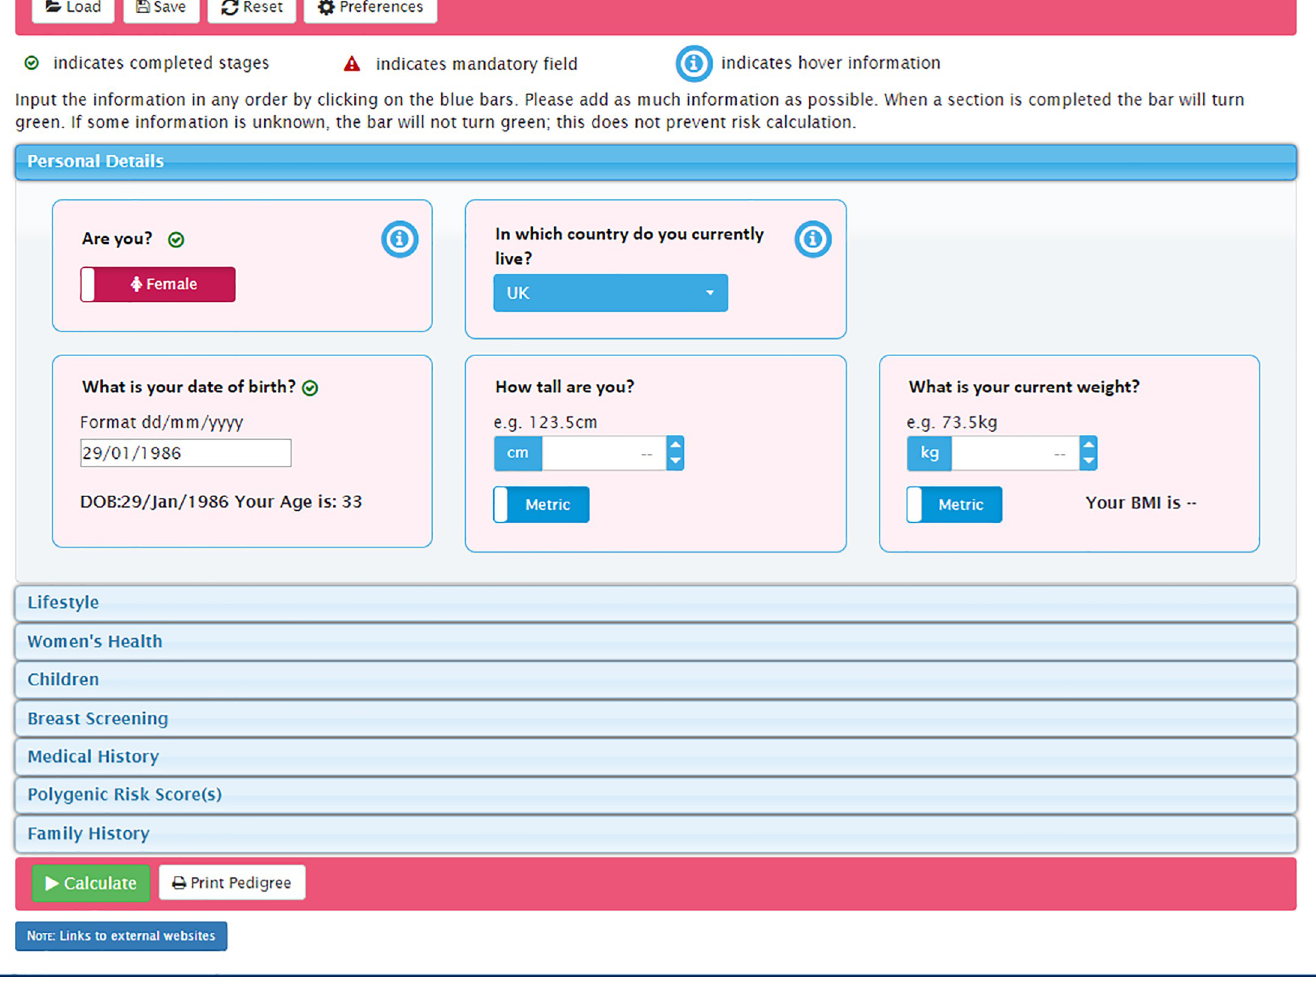
Fig 2. CanRisk tool detailed view of one topic area: Personal Details � . � image corresponds to the revised version of the tool (not the beta version assessed).